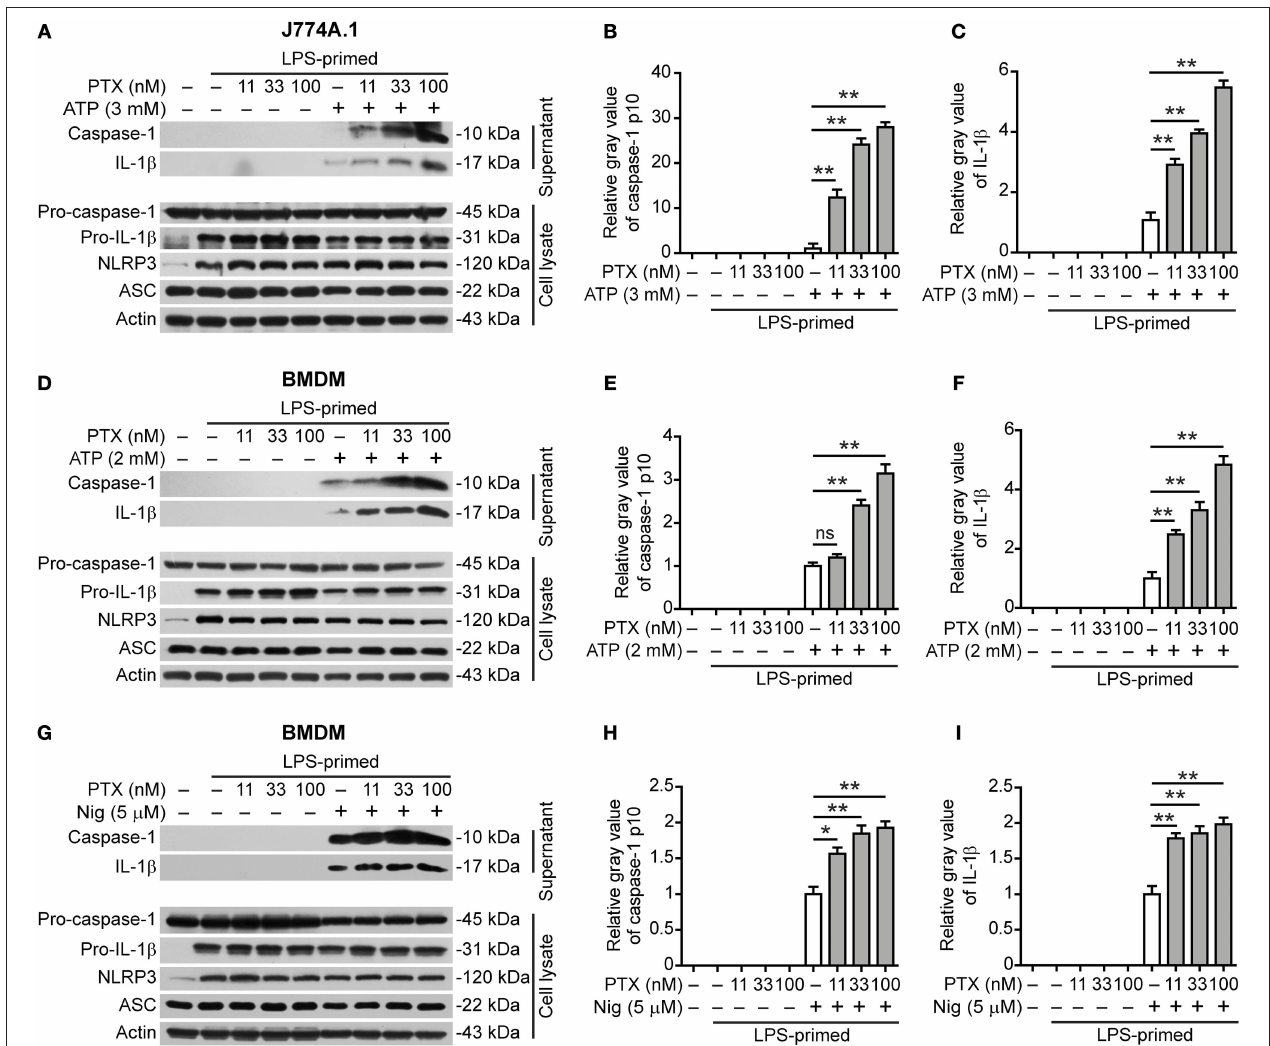
FIGURE 1 | Paclitaxel promoted NLRP3 inflammasome activation in murine macrophages. LPS-primed J774A.1 macrophages were pre-treated paclitaxel for 1h followed by stimulation with ATP (3mM) for 1h, while LPS-primed bone marrow-derived macrophages (BMDMs) were pre-treated with paclitaxel for 1h followed by stimulation with ATP (2mM) for 30min or nigericin (5 µ M) for 1h. (A,D,G) Western blot analysis of indicated proteins in the culture supernatants and cell lysates. Actin was used as a loading control. (B,C,E,F,H,I) Histograms show the gray value of capase-1p10 (10 kDa) or mature IL-1 β (17 kDa) bands in supernatants relative to that of ATP or nigericin group that was set to 1.0, respectively. (B,C) Histograms show quantified data from the results presented in (A) . (E,F) Histograms show quantified data from the results in (D) . (H,I) Histograms show quantified data from the results in (G) . Data were analyzed using the non-parametric Mann–Whitney U -test, which are shown as mean ± SD ( n = 3). * P < 0.05; ** P < 0.01; PTX, paclitaxel; Nig, nigericin.